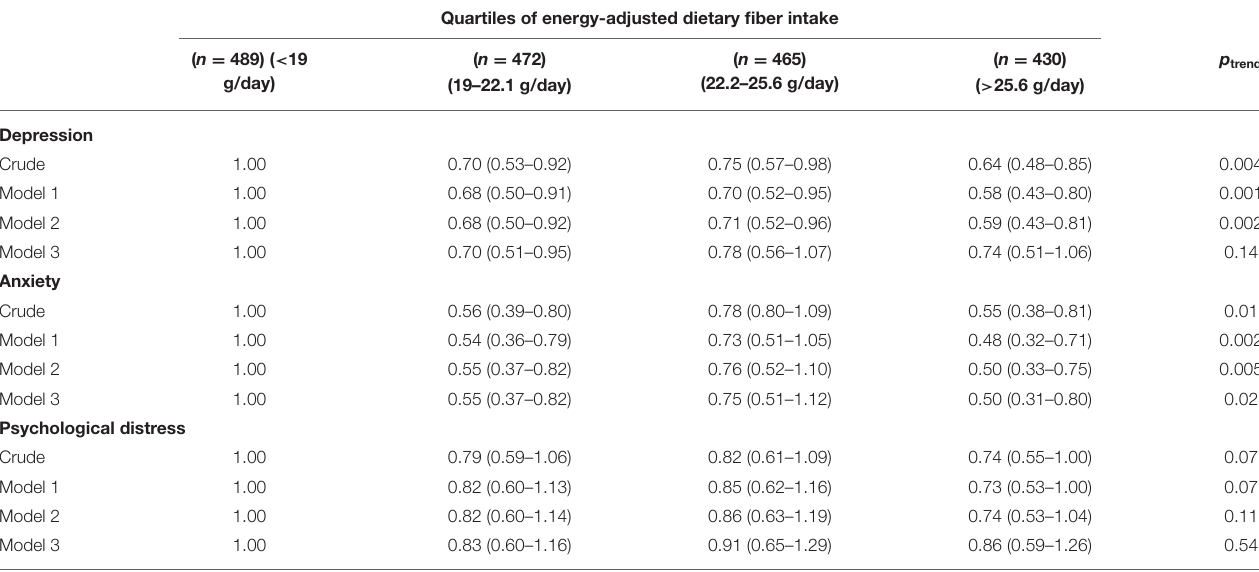
TABLE 7 | Multivariable-adjusted odds ratios and 95% confidence intervals for depression, anxiety, and high psychological distress across quartiles of energy-adjusted dietary fiber intake in normal-weight participants [body mass index (BMI) < 25 kg/m 2 ] ( n = 1,856) a . Quartiles of energy-adjusted dietary fiber